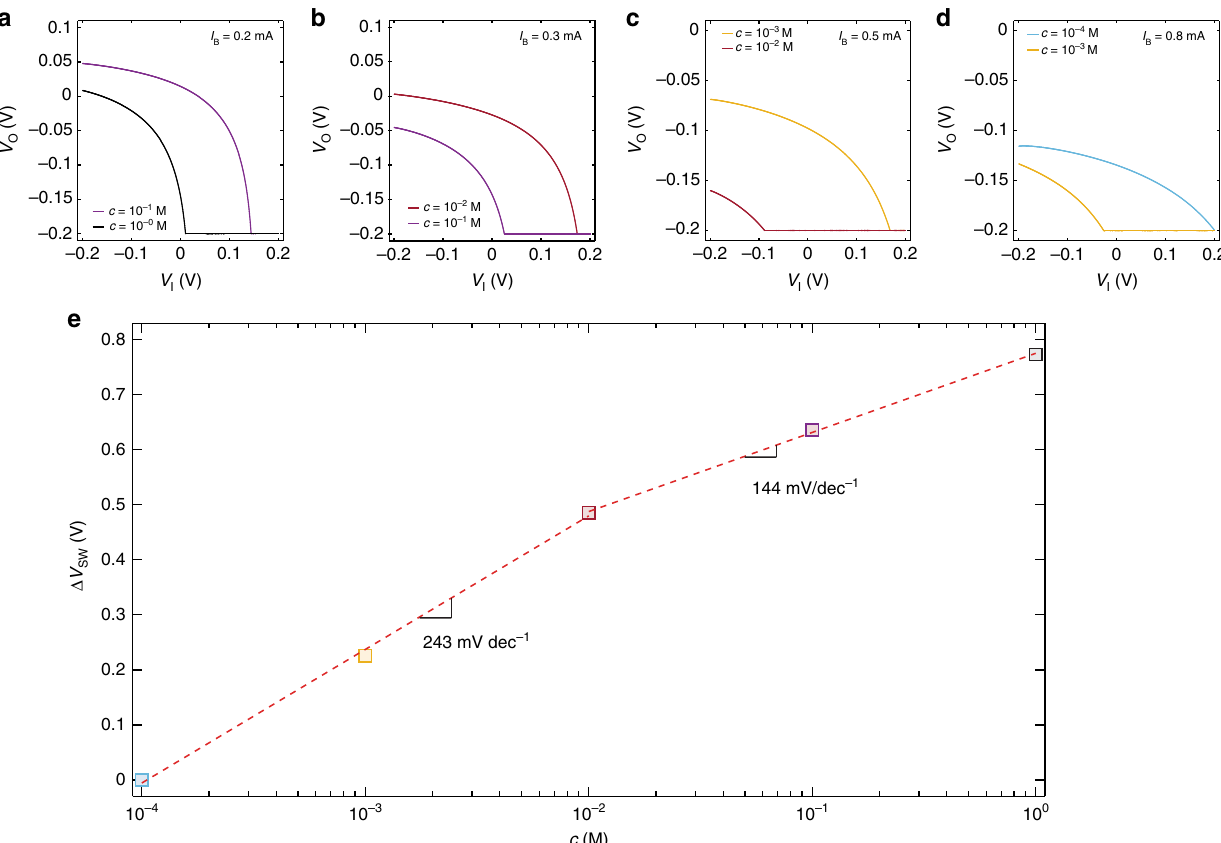
Fig. 5 Ultra-low voltage current-driven OECT. a – d Measured transfer characteristics of the current-driven OECT at several NaCl concentration c , V DD = 0.2 V. a I B = 0.2 mA, b I B = 0.3 mA, c I B = 0.5 mA, d I B = 0.8 mA. e Cumulative switching voltage variation Δ V SWi + 1 = Δ V SWi + ( V SWi + 1 − V SWi ) as a function of the ion concentration. The average sensitivity is of 144 mV dec − 1 in the range 10 − 2 – 10 0 M and 243 mV dec − 1 in the range 10 − 4 – 10 − 2 M. The gate is a Ag/AgCl pellet and the OECTs geometries are: W = 1000 µ m, L = 100 µ m, t = 50